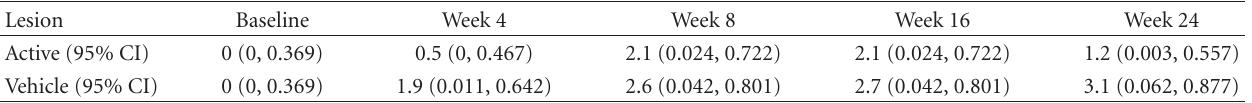
Table 6: Mean lesion counts.